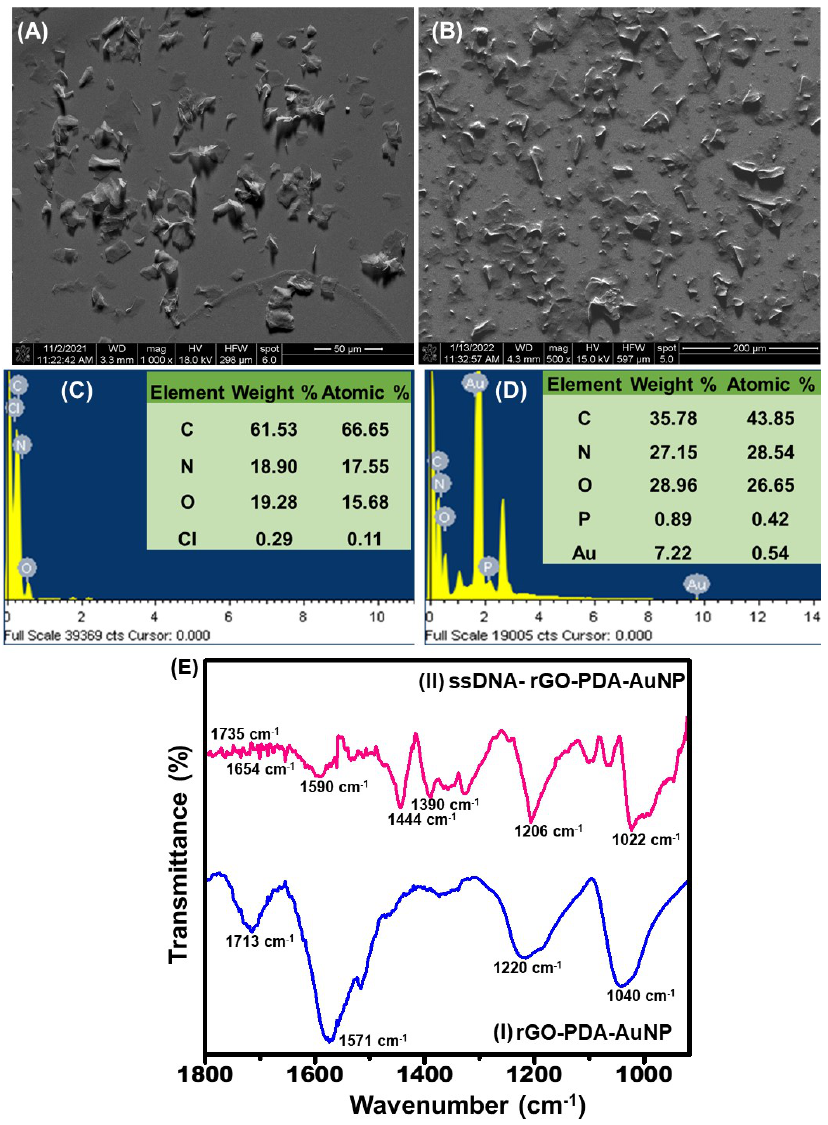
Figure 3. FESEM of ( A ) rGO-PDA, ( B ) ssDNA-rGO-PDA-AuNP, ( C ) EDX analysis of rGO-PDA and Figure 4. This is a figure. Schemes follow the same formatting. If there are multiple panels, they ( D ) ssDNA-rGO-PDA-AuNP, and ( E ) FTIR spectra of (I) rGO-PDA-AuNP and (II) should be listed as: ( a ) Description of what is contained in the first panel. ( b ) Description of what is contained in the second panel. Figures should be placed in the main text near to the first time they are cited. A caption on a single line should be centered.